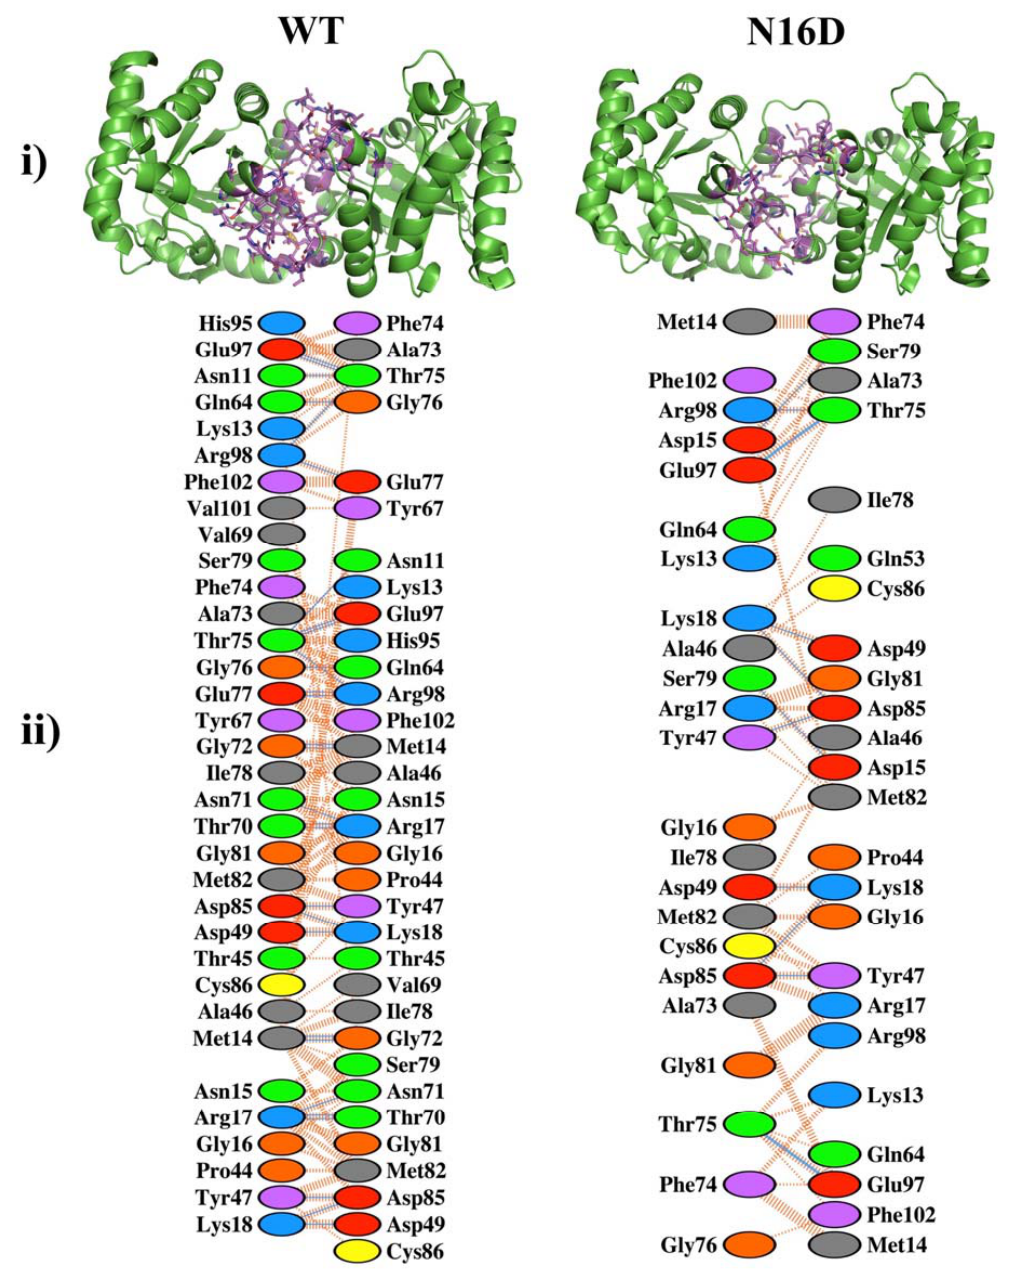
Figure 1. Noncovalent interactions in the interfaces of the nondeamidated (WT) and deamidated (N16D) human triosephosphate isomerase (HsTIM) based on their crystallographic structures. ( i ) The green cartoon is both subunits (dimer) of the WT and N16D HsTIM. The amino acids involved in the noncovalent interactions at the interfaces are shown in purple sticks. ( ii ) The amino acids and their interatomic contacts are depicted at the interfaces of both subunits. Figures were modeled with ( i ) PyMOL [28] and ( ii ) PDBsum-EMBL-EBI [29]. In ( ii ), the color code of ovals represents the properties of the side chain of the amino acids: positive (blue); negative (red); neutral (green); aliphatic (gray); aromatic (violet); proline (brown) and cysteine (yellow).